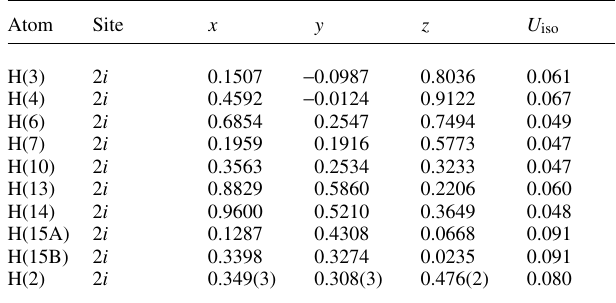
Table 2. Atomic coordinates and displacement parameters (in Å 2 ) .